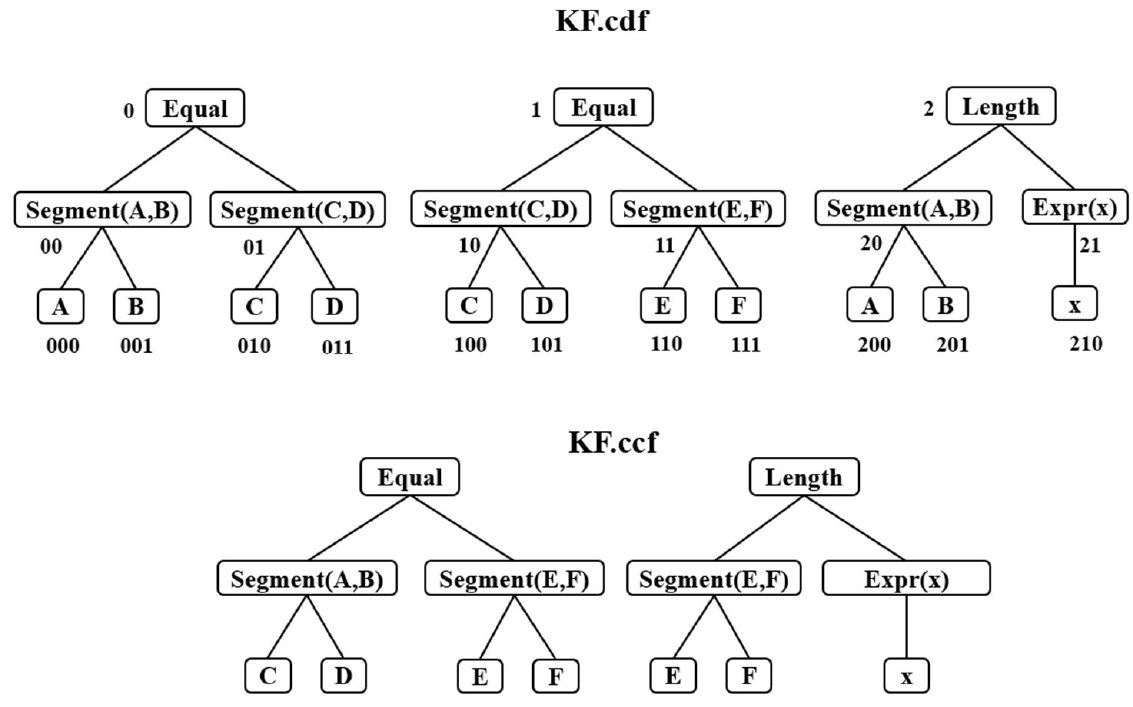
Figure 4. Example of a knowledge forest.